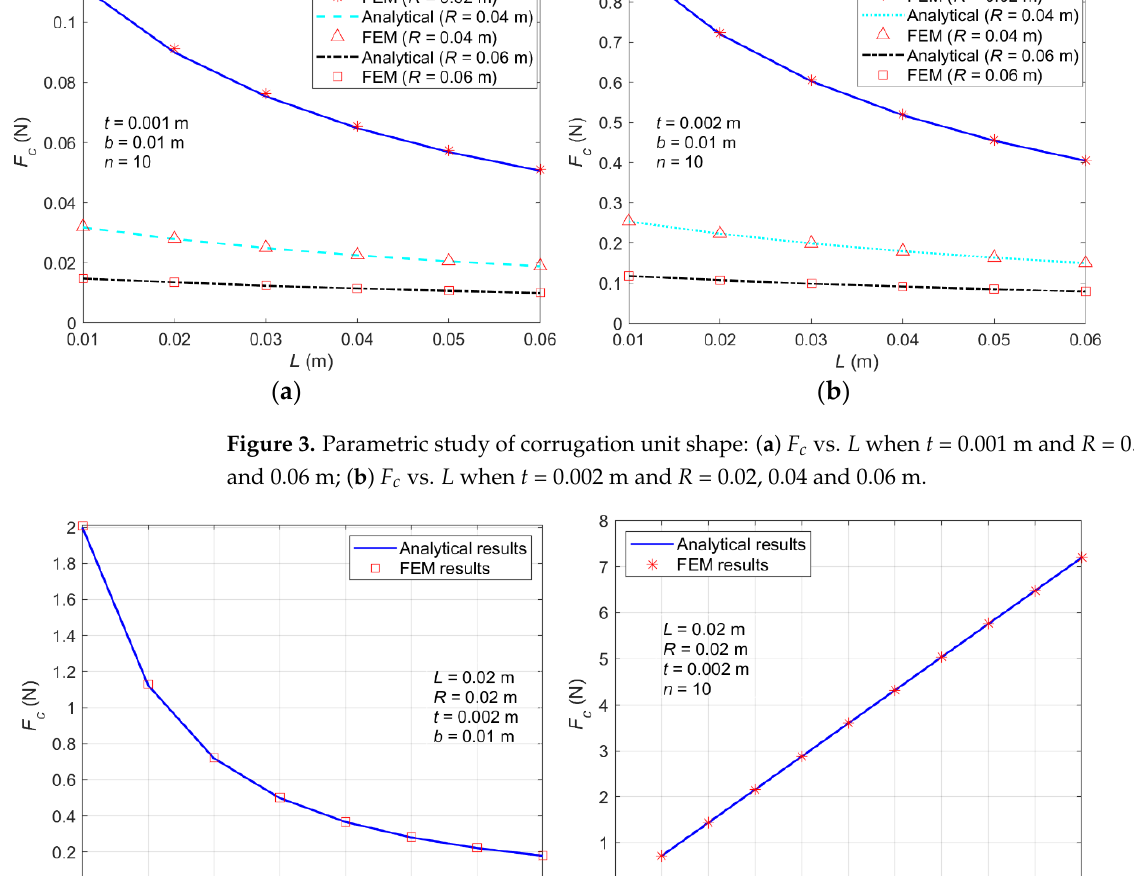
c vs. n , ( b ) F c vs. b